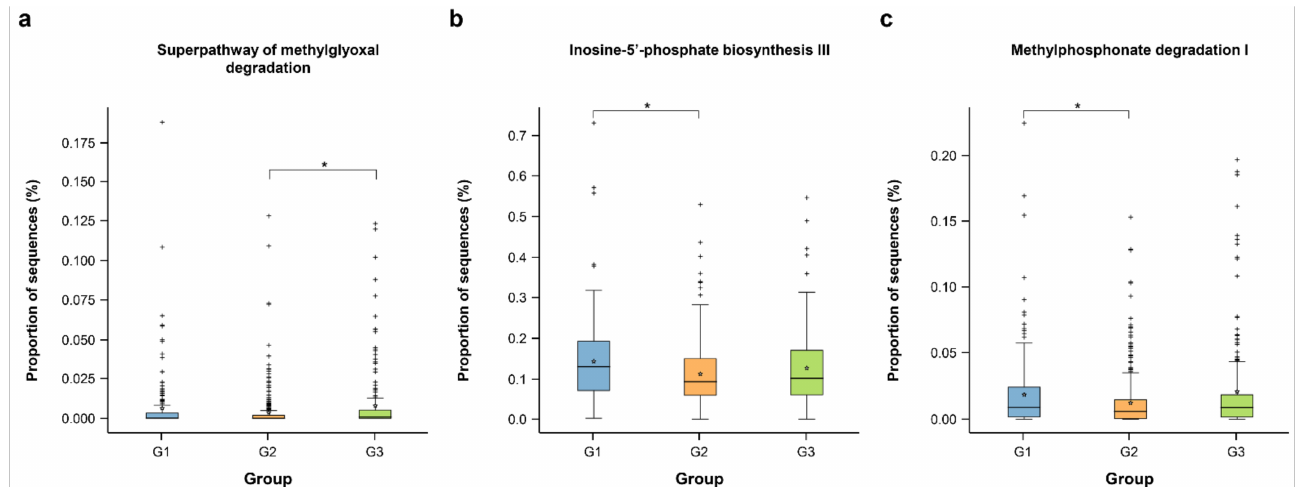
Figure 6. Predicted functional pathways were differentially abundant among the PSA groups. Pathway Database (Metacyc) pathways using PICRUSt2 analysis. ( a ) Superpathway of methylglyoxal degradation was more abundant in the G3 group than in the G2 group ( q = 0.032), ( b ) inosine 5 (cid:48) -phosphate biosynthesis III ( q = 0.037), and ( c ) methylphosphonate degradation I ( q = 0.041) were more abundant in the G1 group than in the G2 group. The box plots denote the top quartile, median, and bottom quartile, and the white stars represent the average value. All differences were analyzed using MaAsLin2 with adjusting for age and sex. The Benjamini–Hochberg FDR method was used to correct multiple comparisons. * q <